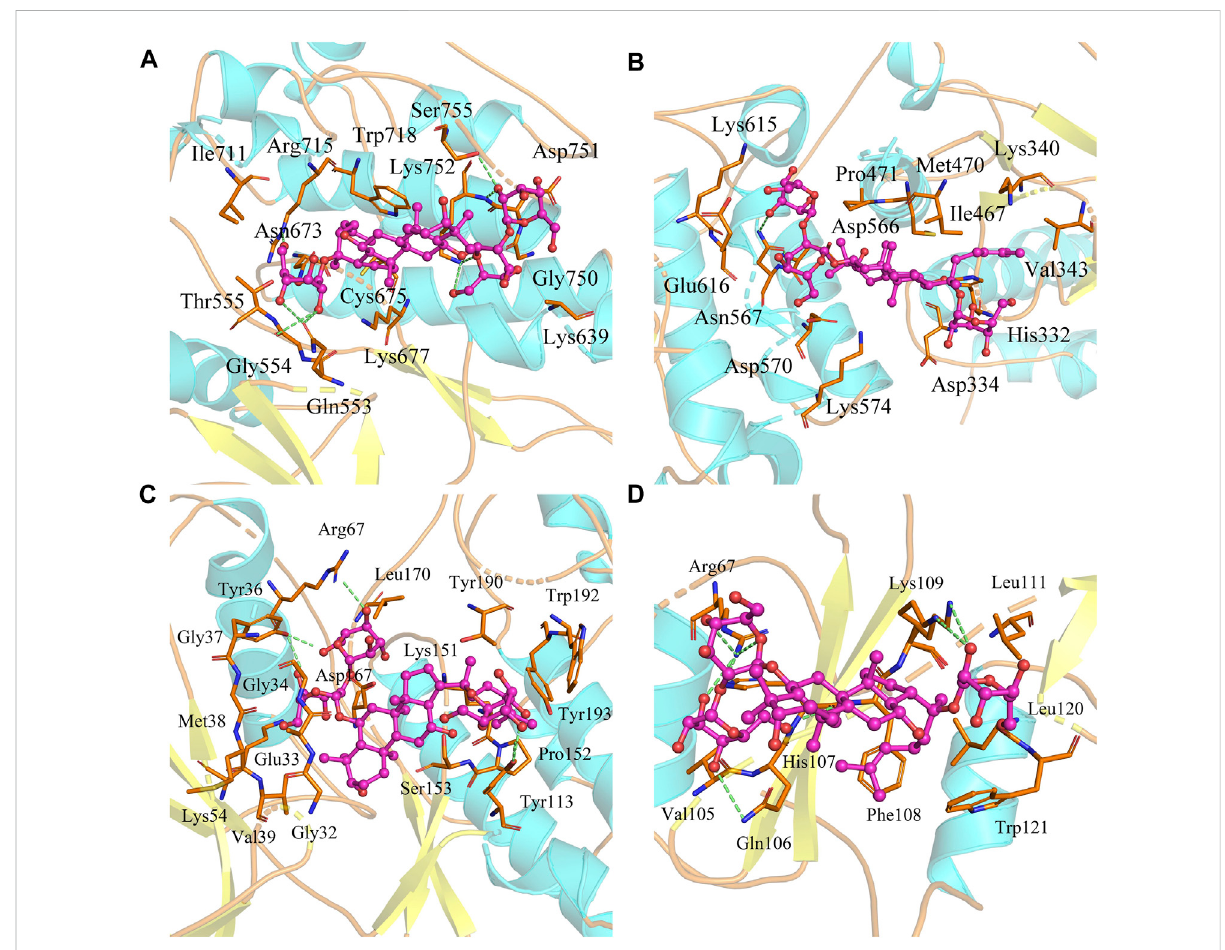
FIGURE 5 MoleculardockingconformationofGS-Rdandhubgenes. (A) JAK2(dockingaf fi nityscore:7.5) (B) STAT3(dockingaf fi nityscore:6.7) (C) MAPK1 (docking af fi nity score: 8.1) (D) GRB2 (docking af fi nity score: